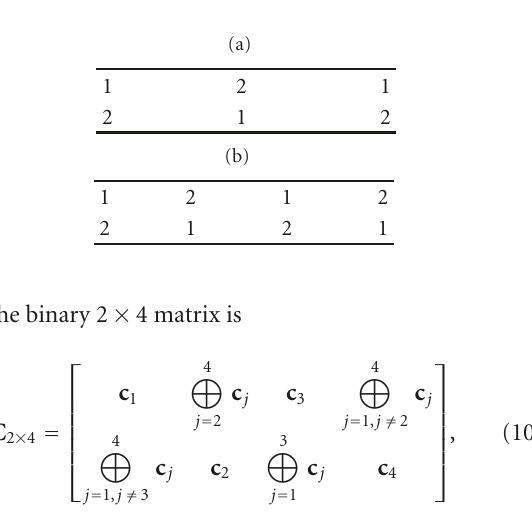
Table 1: The threaded layering in coherent scenario using 2 layers. The numbers refer to thread indexes. The vertical and horizontal axes correspond to the spatial and temporal dimensions, respec-